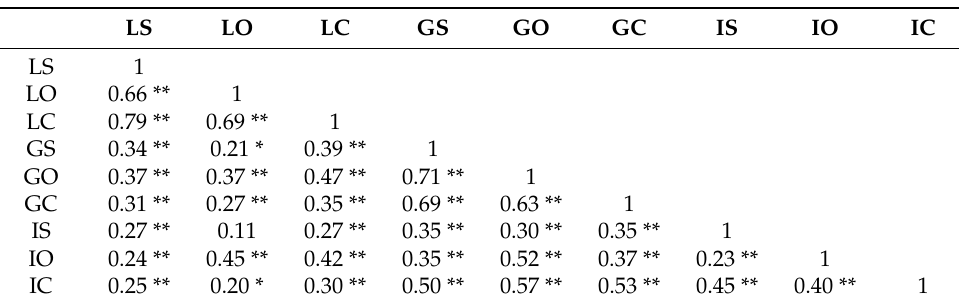
Table A2. Data from dairy